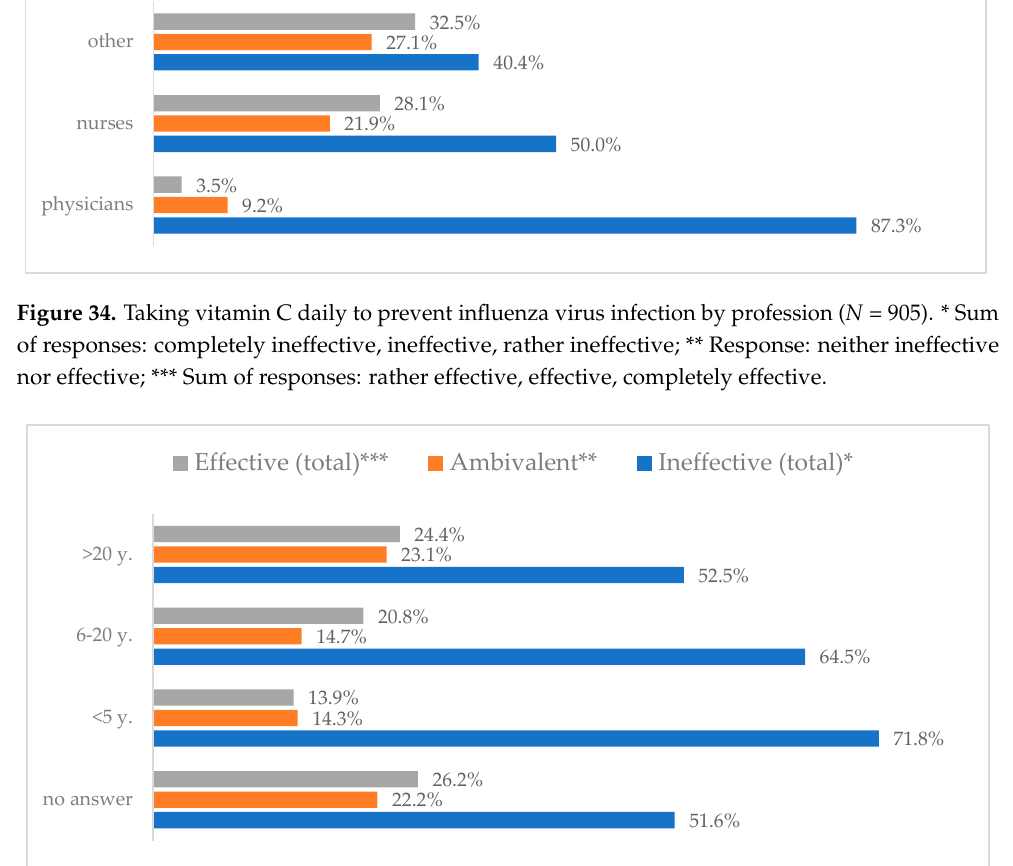
Figure 35. Taking vitamin C daily to prevent influenza virus infection by seniority ( N = 905). * Sum of responses: completely ineffective, ineffective, rather ineffective; ** Response: neither ineffective nor effective; *** Sum of responses: rather effective, effective, completely effective.